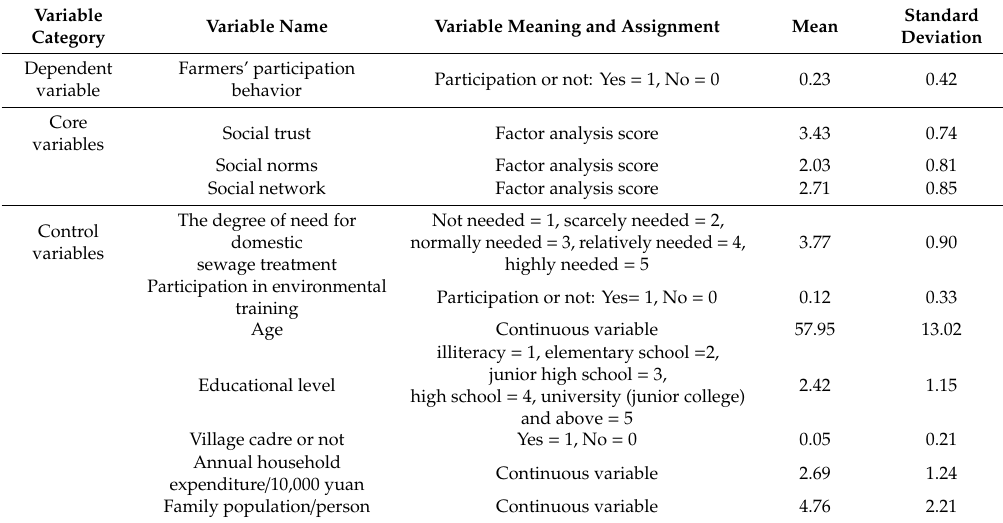
Table 1. Variable meaning and